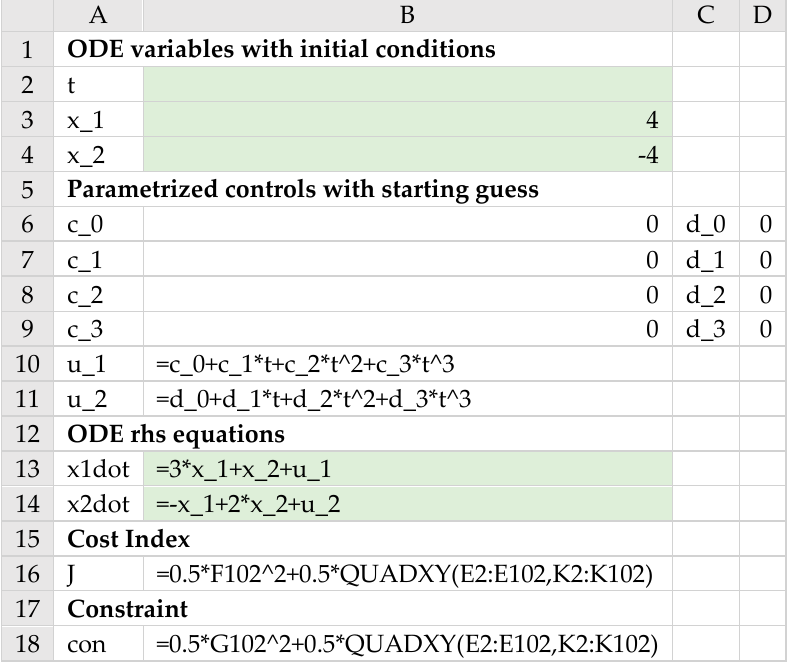
Figure 9 . Spreadsheet parametrized model for problem 3.2. The colored ranges are inputs for IVSOLVE formula (16).